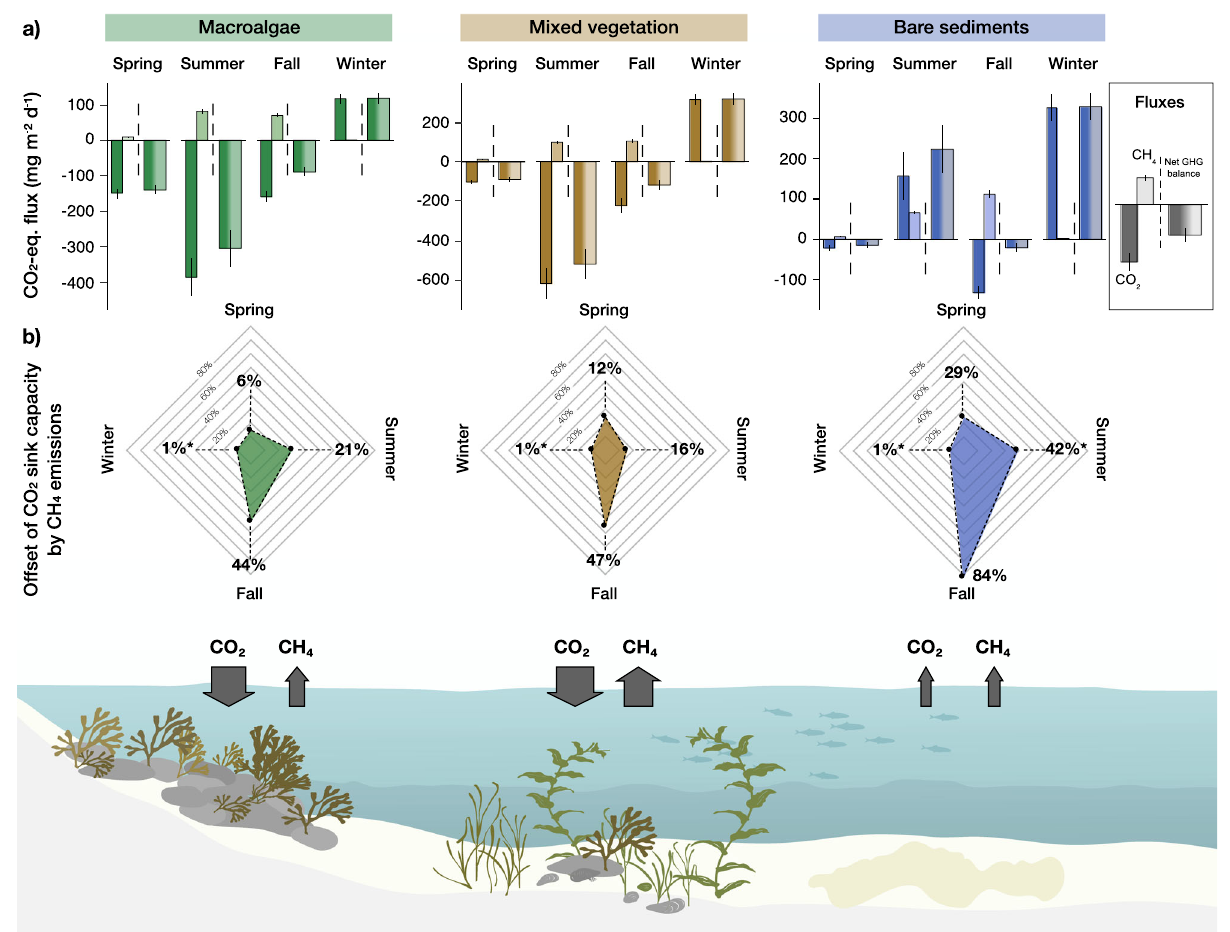
Fig.2|Seasonalnetgreenhousegasbalances. Dailymeannet fl uxesofCO 2 ,CH 4 , and the net greenhouse gas balance (all expressed in CO 2 -eq. fl uxes) ( a ), and the offset (in %) of the carbon sink capacity attributed to atmospheric CO 2 uptake by CO 2 -eq CH 4 emissions ( b ). Values in a are means ± standard error. Positive fl uxes refer to an ef fl ux from the water to the atmosphere (source), while negative fl uxes depict an uptake of atmospheric GHGs (sink). CO 2 -equivalent CH 4 fl uxes were calculatedusing thesustained- fl ux globalwarming potential(SGWP) on a 100-year timehorizonof45 21 .ThenetgreenhousegasbalanceiscalculatedbasedonnetCO 2 andnetCO 2 -eq.CH 4 fl uxes.Theoffsetin(b)iscalculatedfromthenetCO 2 fl uxand